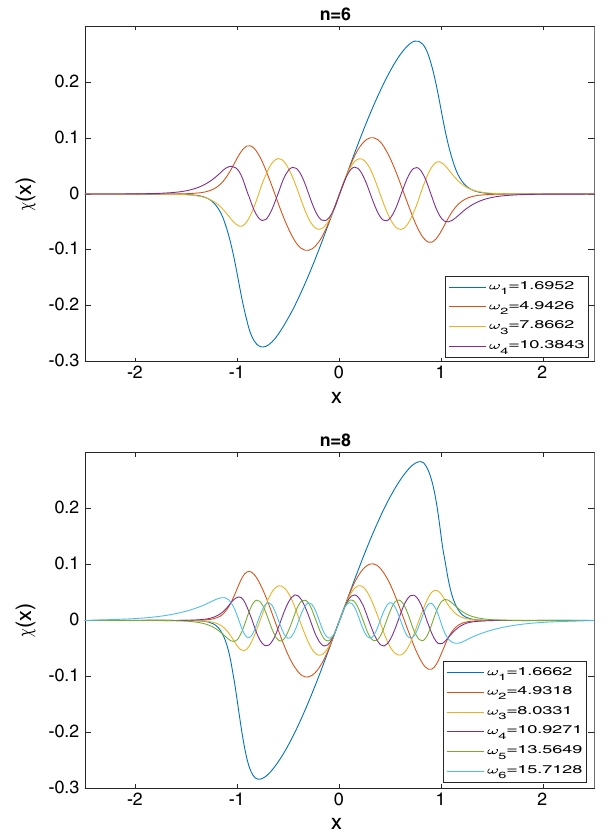
Fig. 3 The eigenfunctions χ( x ) associated to the internal modes of the compactlike structures with n = 6 and n = 8. In the inset, we display the corresponding eigenfrequencies